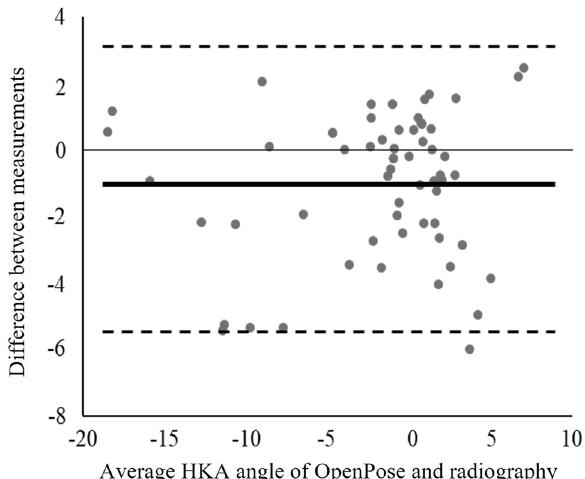
Figure 2. Bland–Altman plot for assessing measurement error. Mean hip-knee-ankle angle measurements for OpenPose and radiography are plotted on the x-axis and the difference between measurements on the